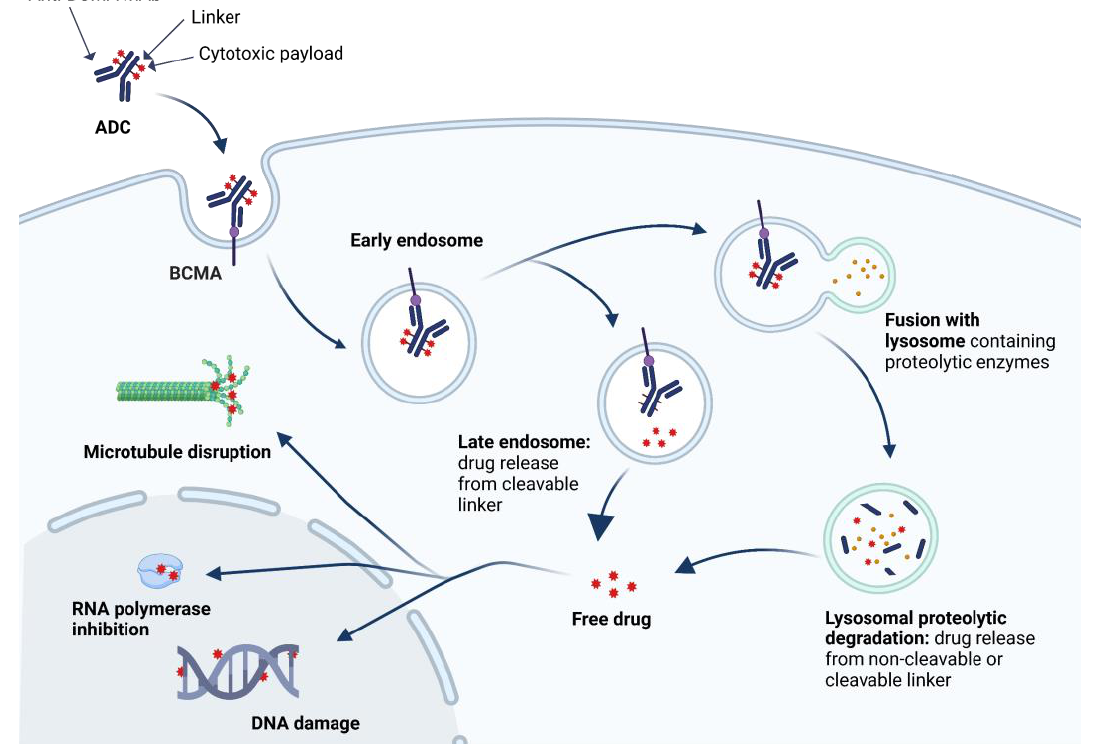
Figure 1. General mechanism action of an anti-BCMA ADC in myeloma cell. Created with BioRen- der.com. Table 1. Summary of current clinical trials of anti-BCMA ADC.